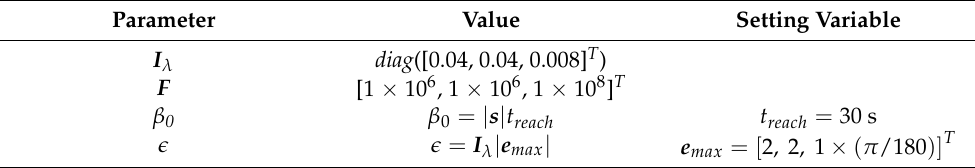
Table 4. Control parameters for the sliding mode